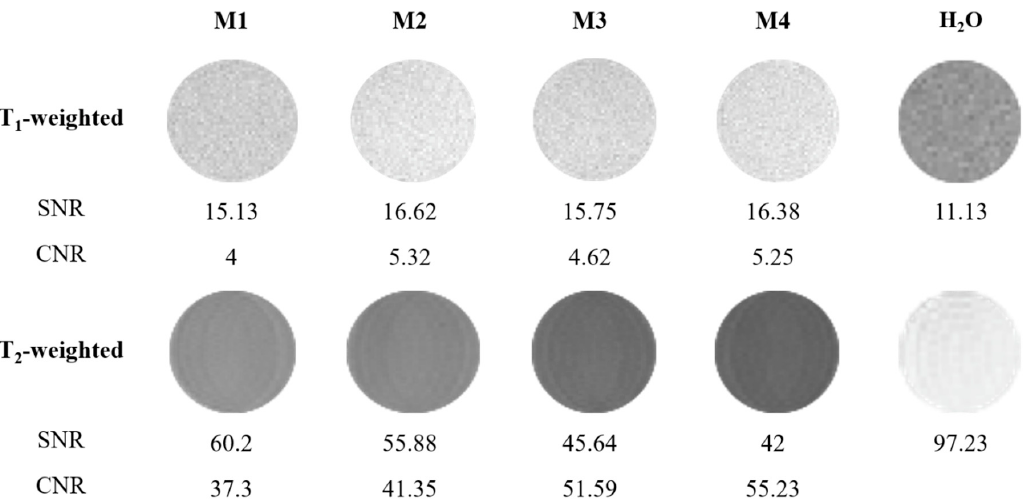
Figure 5. Magnetic resonance (MR) images of AuBSA-Fe phantoms (denoted as M1–M4) containing different Fe concentrations (807 μ M Fe in M1, 1020 μ M Fe in M2, 1193 μ M Fe in M3, and 1249 μ M Fe in M4) and water phantom (H 2 O), measured at 4.7 T external magnetic field. T 1 - and T 2 -weighted MR images are shown. Note: the signal-to-noise ratio (SNR) was calculated using SNR = 0.655 × S/ σ , where S is signal intensity in the region of interest (ROI), σ is the standard deviation of background noise, and the constant 0.655 reflects the Rician distribution of background noise in a magnitude MR image. Eight averages were used.